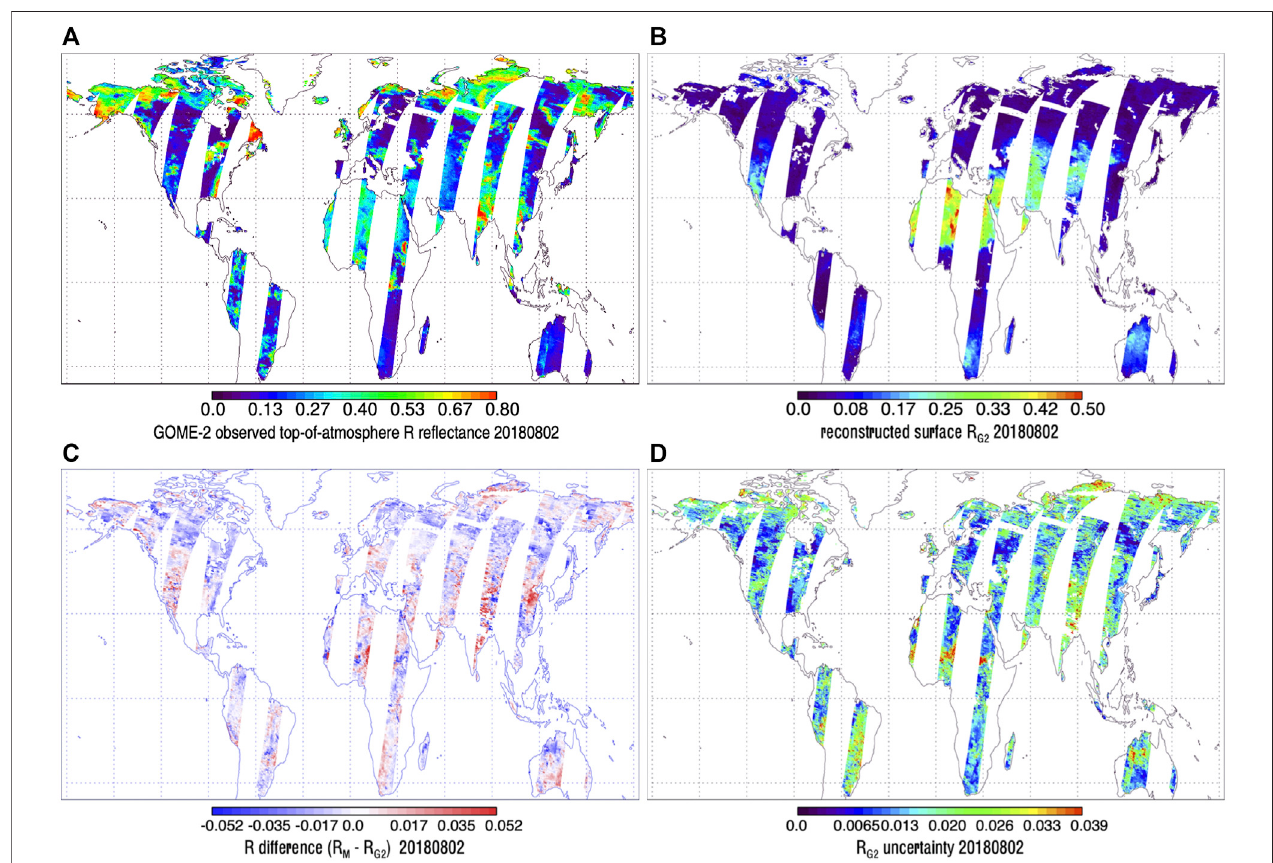
FIGURE 6 | Results for GOME-2 red (R) re fl ectances on August 2, 2018: (A) GOME-2 original R re fl ectance ( ρ R ) to show presence of clouds (generally higher re fl ectances) (B) reconstructed from GOME-2 (R G2 ); (C) surface re fl ectance difference map, collocated MODIS MCD43 R M minus R G2 ; (D) estimated R G2 uncertainties. Maps for (B – D) show only for GOME-2 pixels with observed red R < 0.6.